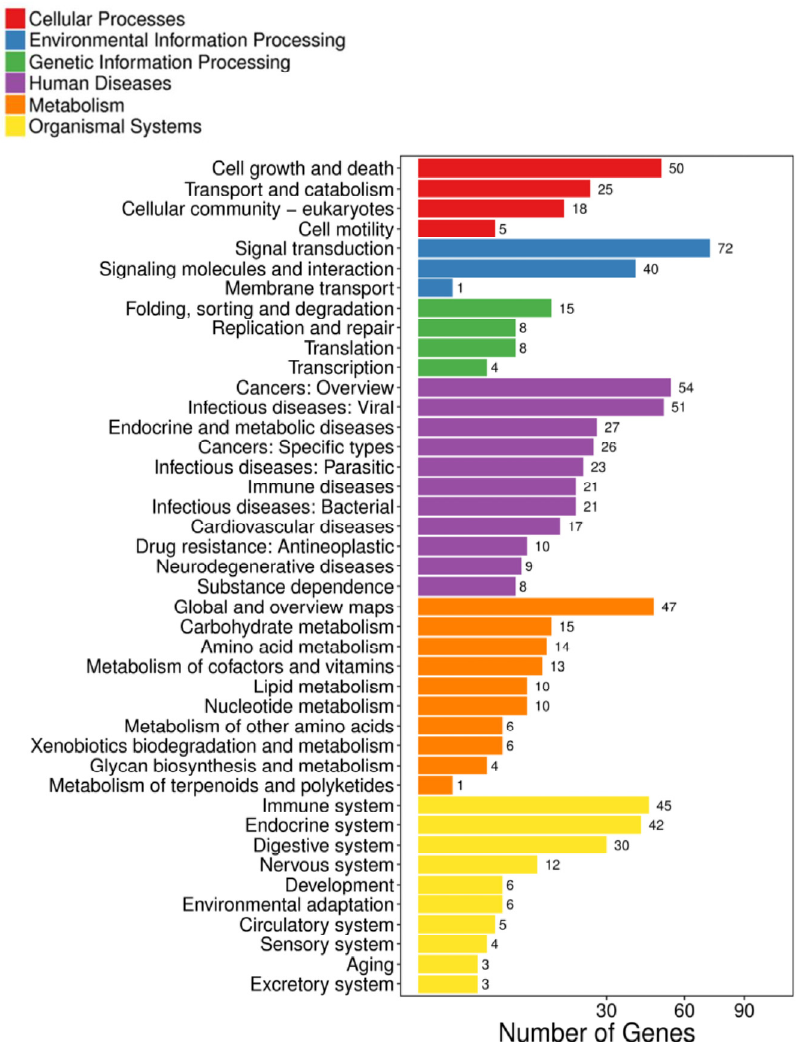
Figure 2. Pathway classification of DEGs in SW/SFW group. X -axis represents the number of DEGs, and the Y -axis indicates the functional classification of KEGG that has been further classified into seven categories: cellular processed, environmental information processing, genetic information processing, human disease, metabolism, and organismal systems. The signaling transduction under the environmental information processing was enriched by the highest DEGs (72 genes). Immune system (45 genes) was the top enriched term in organismal systems.